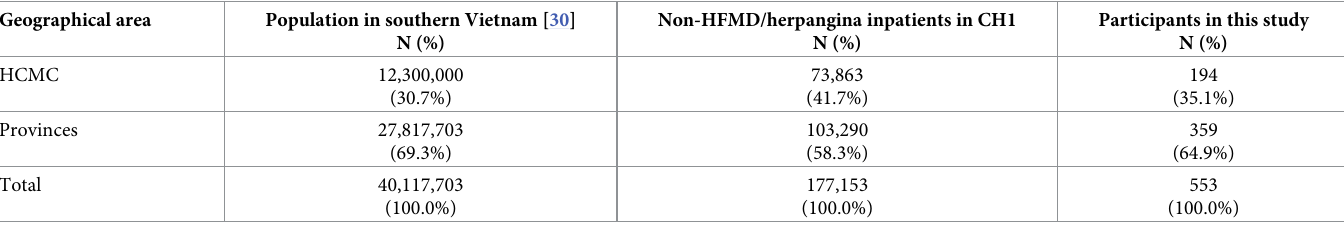
Table 2. Geographical distribution of study participants, all non-HFMD/herpangina inpatients of CH1, 2012–2013, and population in southern Vietnam. Geographical